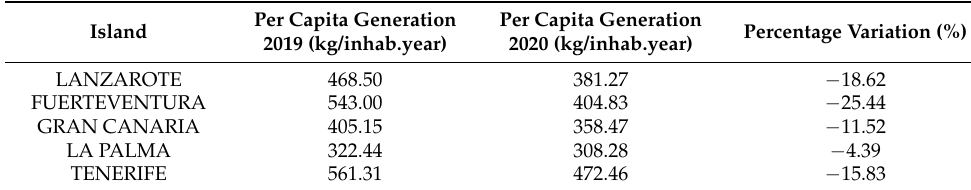
Table 3. Per capita variation in production of mixed municipal waste fraction based on April 2020 data [35]. Per Capita Generation Island 2019